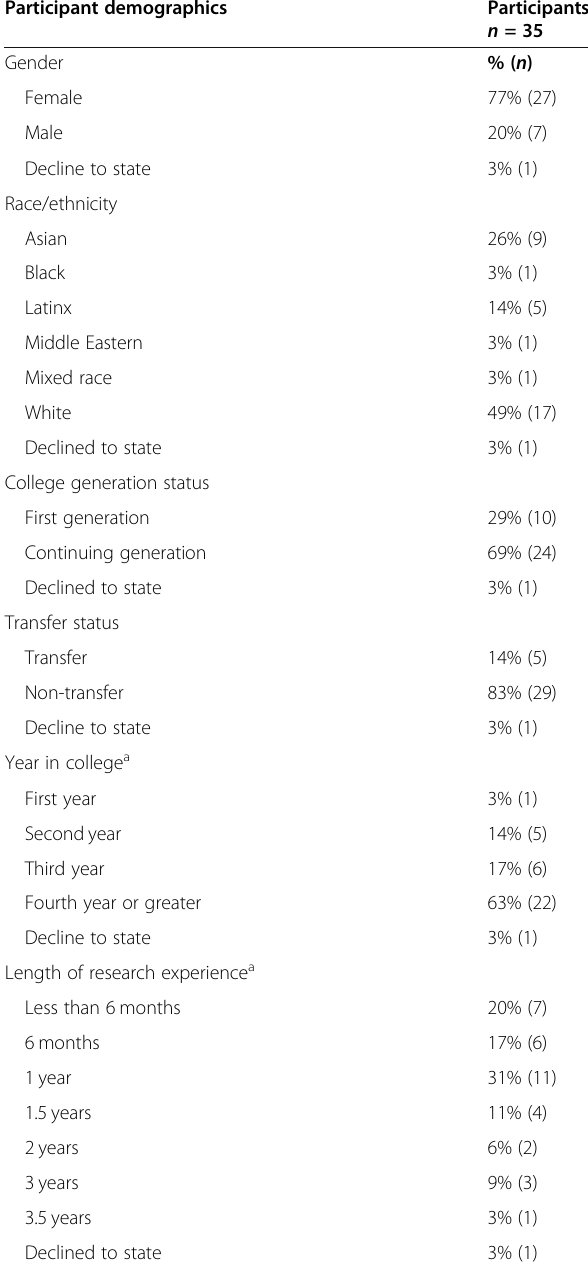
Finding 1.1: Factors that influence students ’ choices to conceal their depression in undergraduate